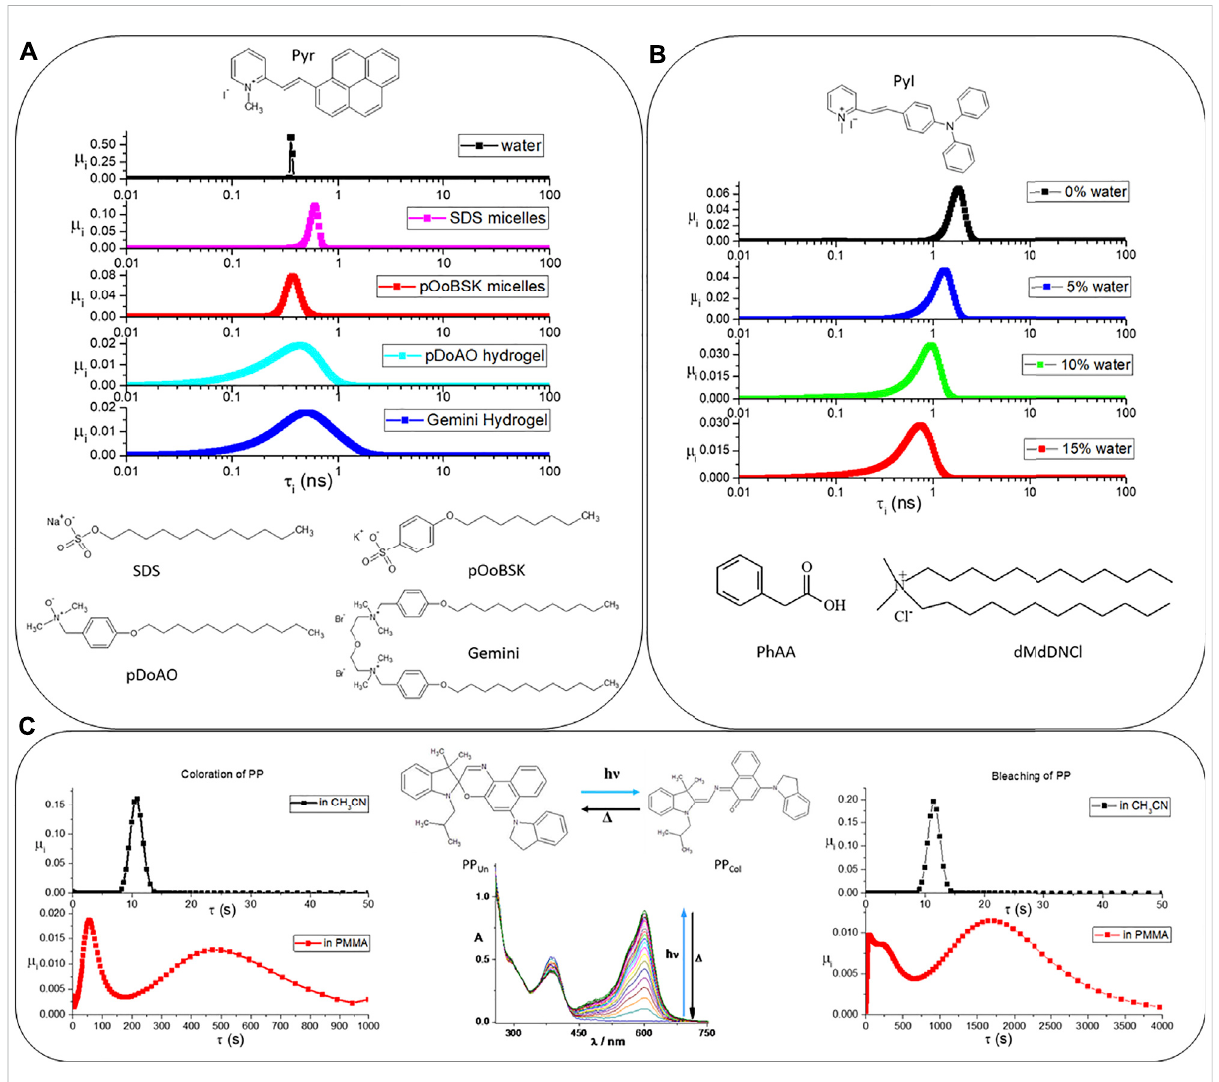
FIGURE 2 In (A) , the fl uorescence lifetimes ’ distributions of Pyr in water (black points), SDS micelles (pink points), pOoBSK micelles (red points), pDoAO hydrogel (cyan points), and Gemini hydrogel (blue points) are shown. In (B) , the fl uorescence lifetimes ’ distributions of PyI in PhAA/dMdDNCl after adding 0% (black points), 5% (blue points), 10% (green points), and 15% (red points) of water are reported. In (C) , the photochromism of PP (see the molecular structures of both colored and uncolored forms and the spectra recorded upon UV irradiation) has been investigated in acetonitrile and in PMMA. The plots containing the black points refer to the distributions of lifetimes for the coloration (on the left) and bleaching (on the right) kinetics in acetonitrile. The plots below, with red dots, refer to the same kinetics collected in